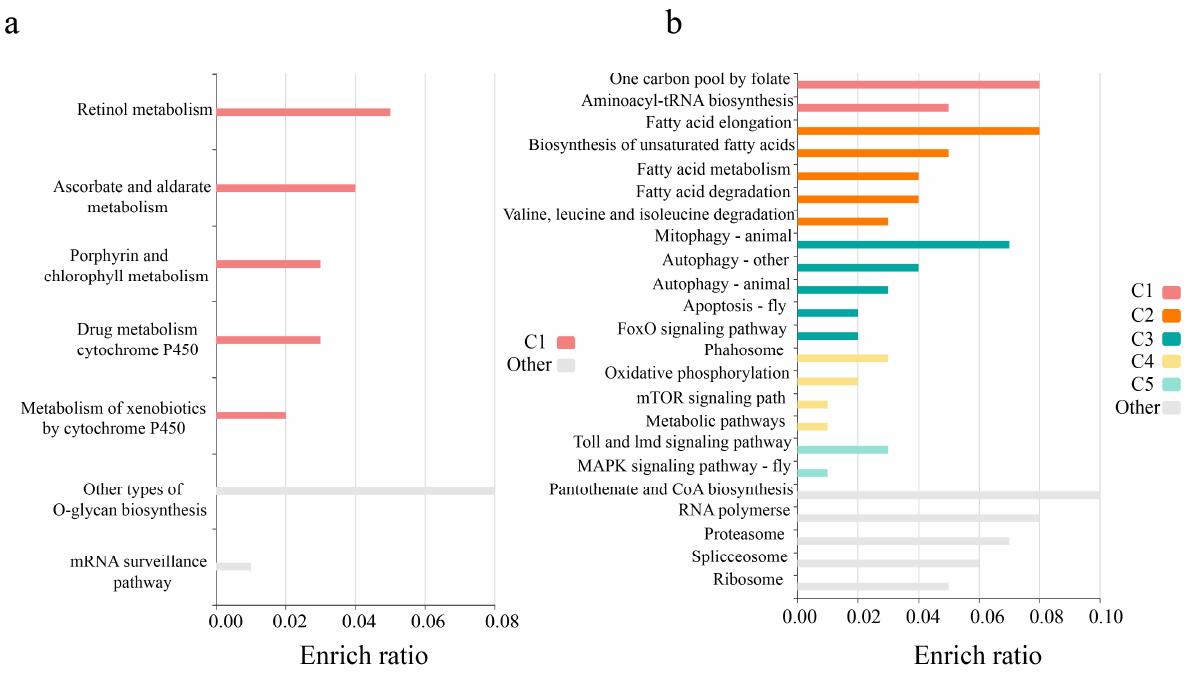
Figure 5. Results of KEGG enrichment analysis genes undergone species-specific positive selection in T . meditationis . Genes were identified by ( a ) the free-ratio model or ( b ) the branch-site model in